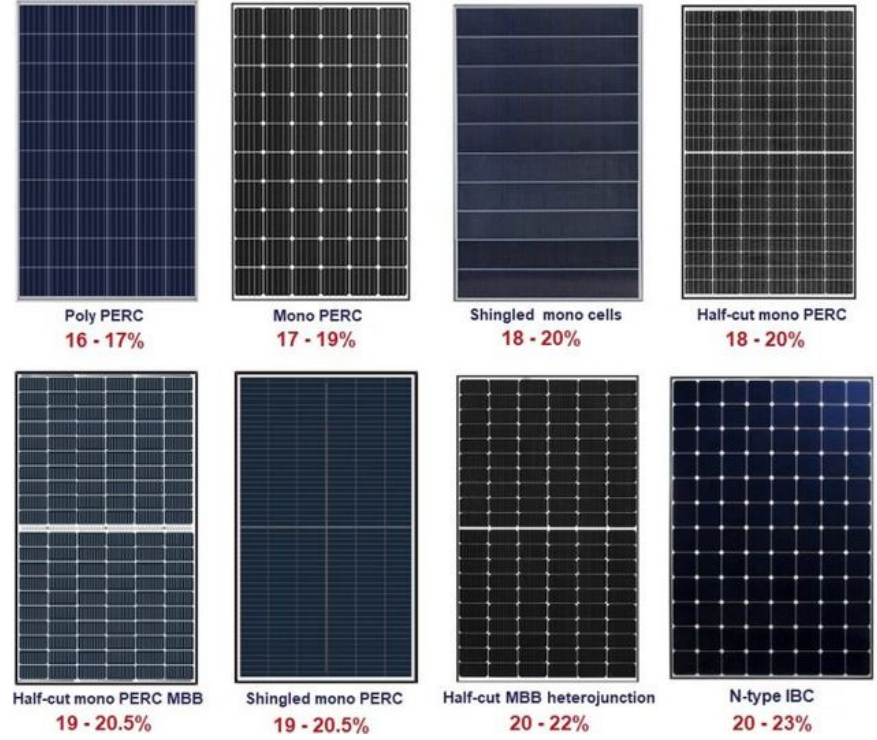
Figure 5. Different, new PV technologies which are available on the market [65]. Table 3. PV technologies which are highly efficient [66].